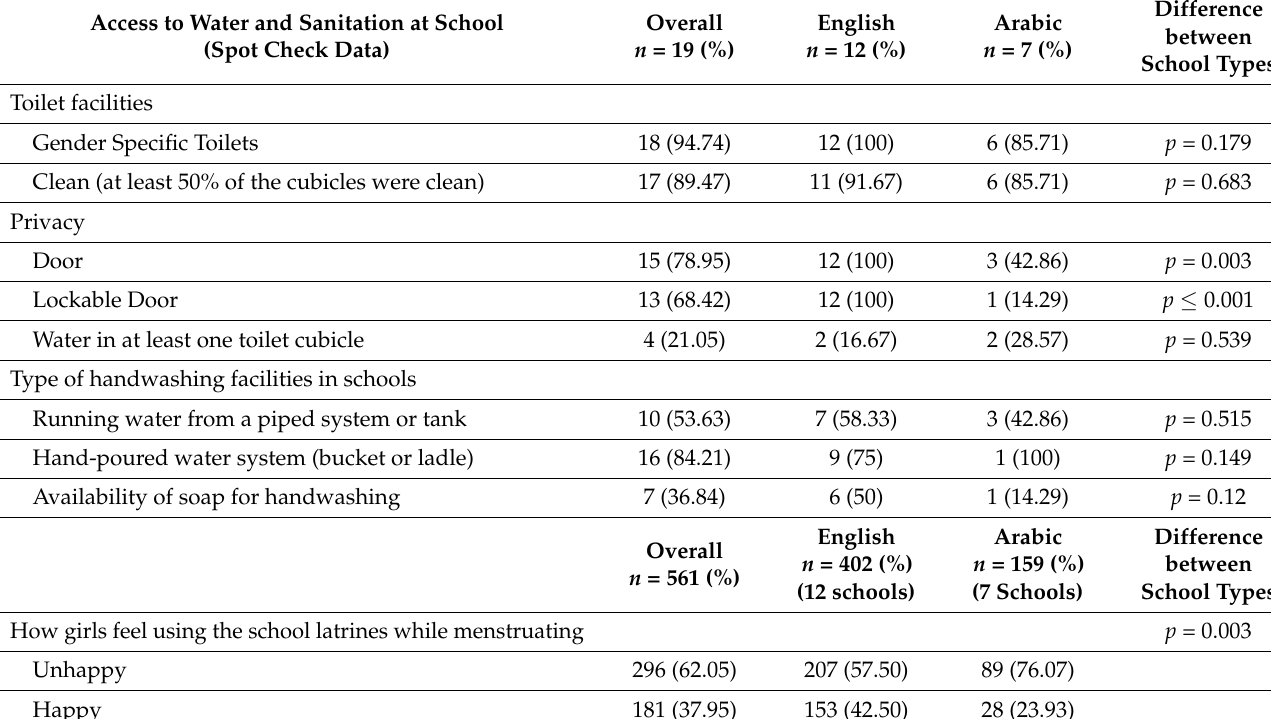
Table 4. Access to water and sanitation at